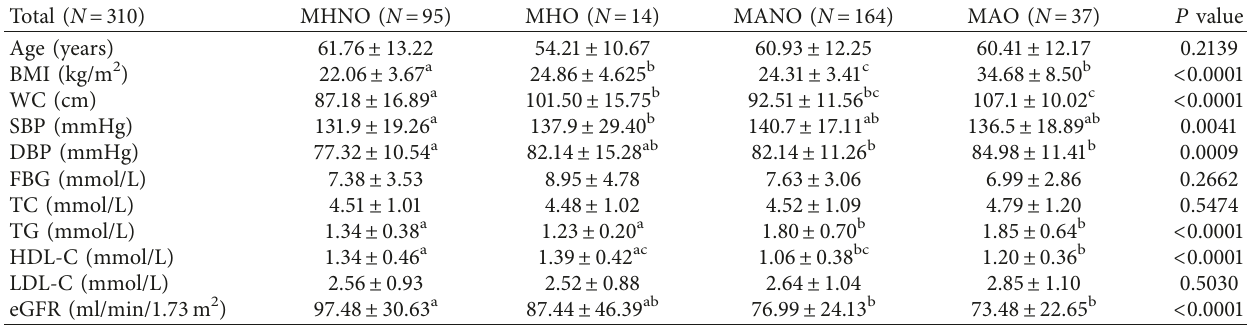
Figure 1: Prevalence of obese phenotypes among the study Table 2: Metabolic parameters of metabolic healthy nonobese (MHNO), metabolically healthy obese (MHO), metabolic abnormal nonobese (MANO), and metabolic abnormal obese (MAO) subjects.